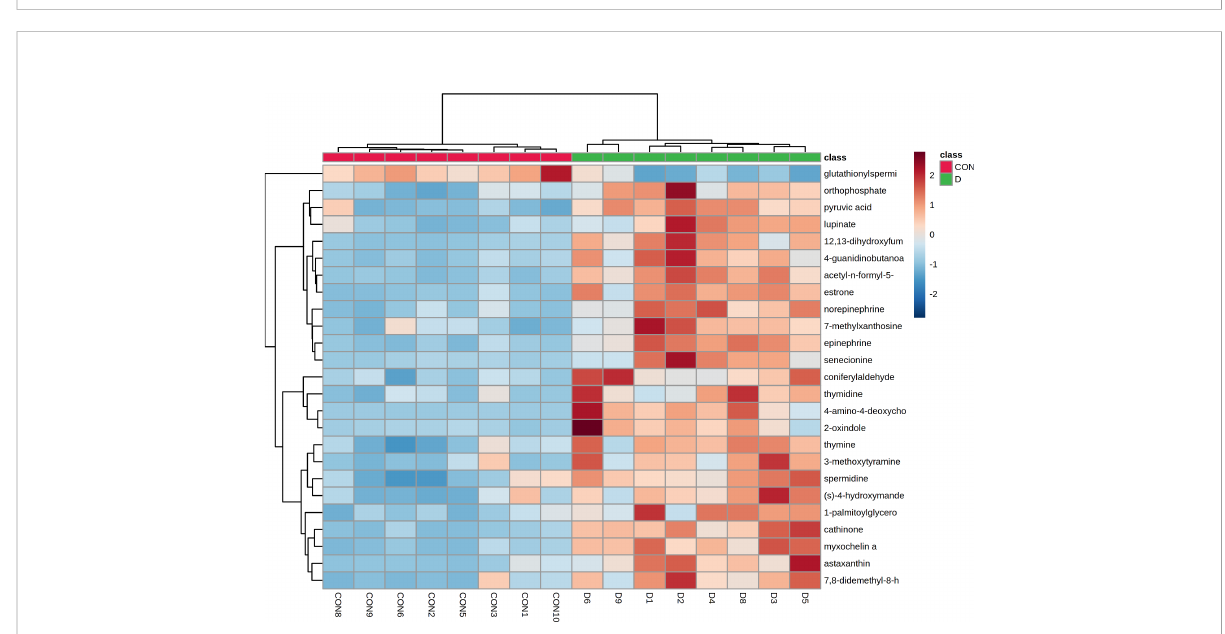
FIGURE 13 Heat-map of hierarchical clustering analysis of top 30 altered metabolites in the caecal contents of EP+YG vs control groups broiler